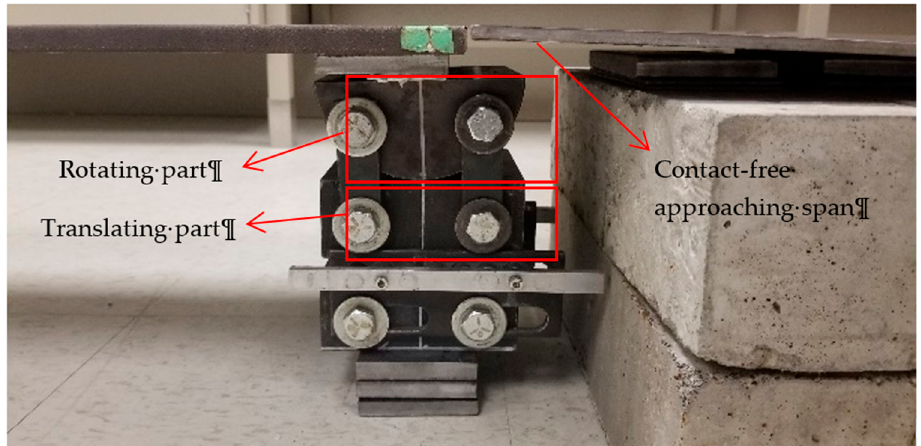
Figure 7. Pin-roller support setup.